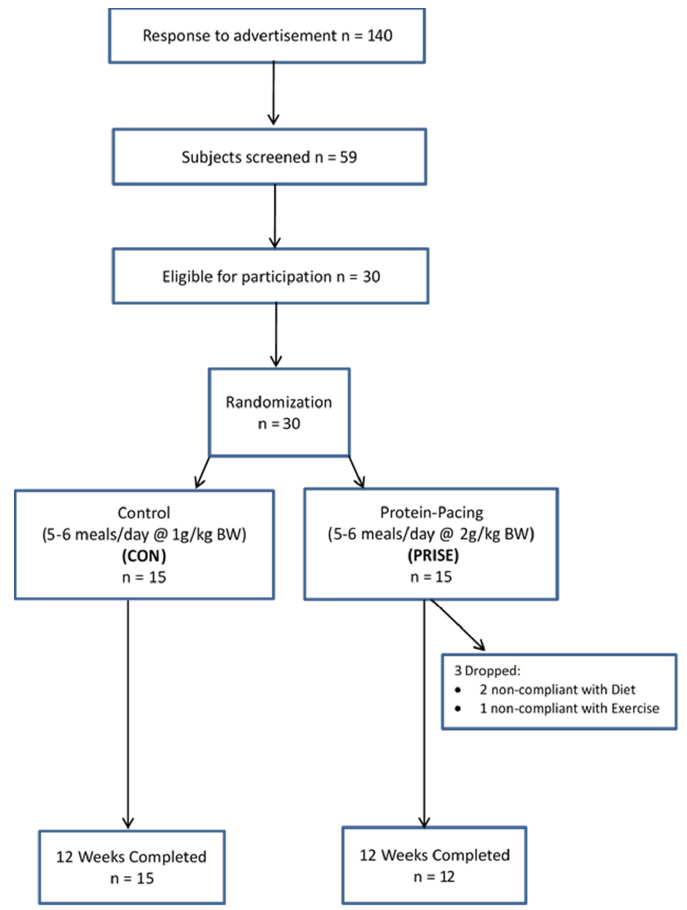
Figure 1. CONSORT flow chart of participants during the intervention.